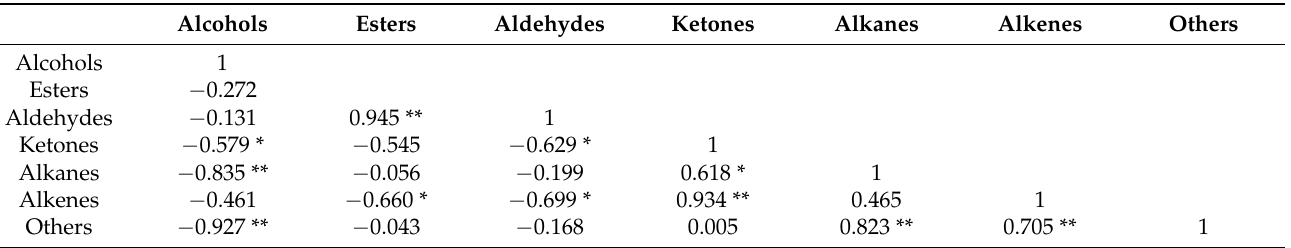
Table 3. Linear correlation coefficients among different classes of volatile compounds.